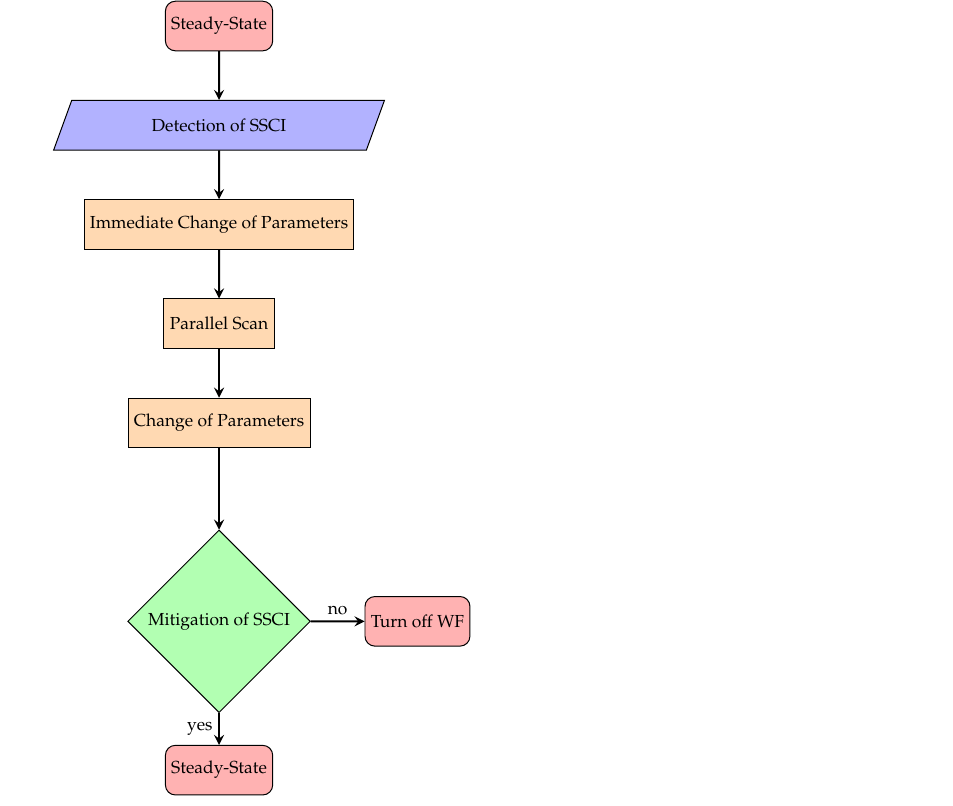
Figure 6. Flowchart of SSCI mitigation